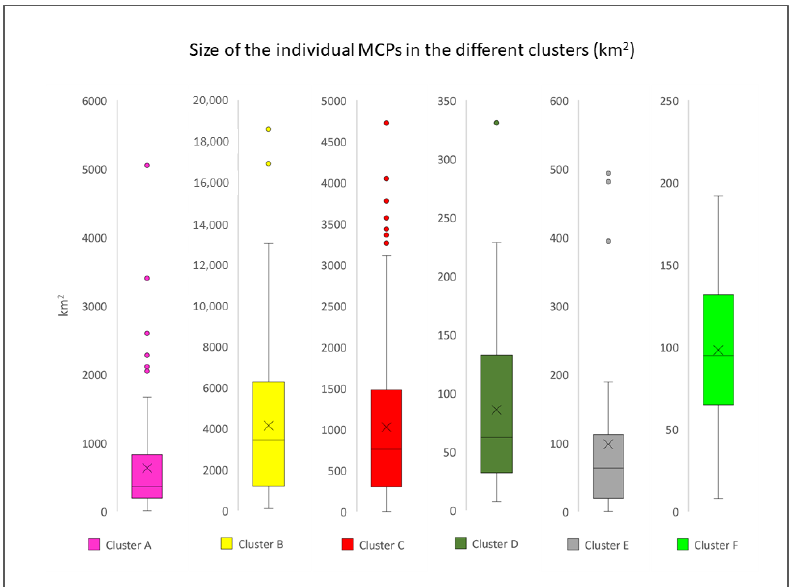
Figure 8. Boxplot analysis of the MCPs surface areas (km 2 ) for each cluster (each boxplot has a different scale). For each cluster, the single MCPs were overlapped to obtain the complex multi-pol- ygons (MPs), which represent an approximation of the area of occupancy of the different geographical units (Figure 9). The MPs tend to occupy all of the continental platform (CP), with the clear exception of cluster E, whose MP takes only a small portion of the available